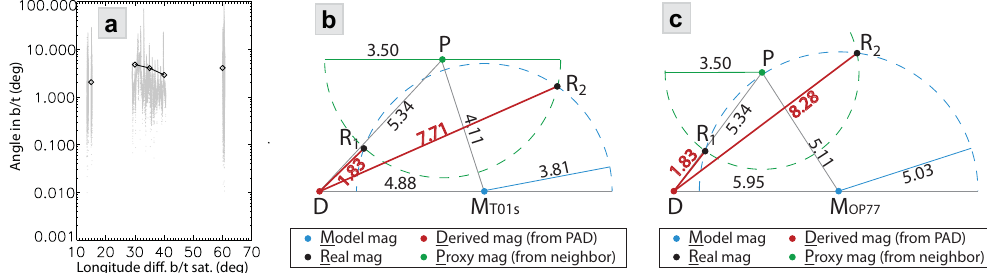
Figure 7. Determining the position of R point(s) using proxy magnetic field. (a) Deviation angles between proxy and measured field directions, in three selected periods, are plotted against the longitude separations between each pair of GOES satellites. Overplotted data symbols are averaged angles for binned longitude separations. (b) The introduction of the point P and the PR circle generate R 1 and R 2 intersection points when T01s model is used. (c) The introduction of the point P and its circle generate another pair of R 1 and R 2 intersection points when OP77 model is used.